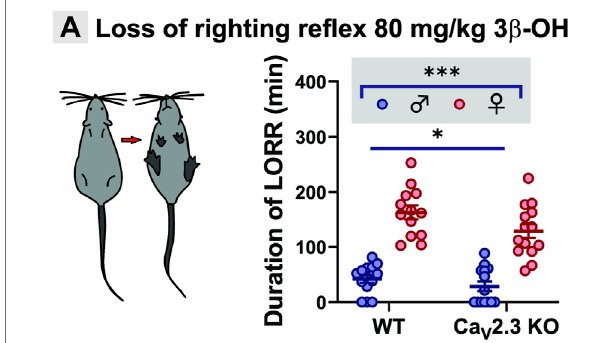
FIGURE 4 | Sex- and genotype-dependent resistance to hypnosis measured by LORR in the Ca V 2.3 KO mice when compared to the WT littermates after i.p. injections of 80 mg/kg 3 β -OH. (A) Left, schematic presentation of LORR experiment; right, average duration of LORR after injections of 3 β -OH (two-way ANOVA: interaction F 1,51 = 0.99, p = 0.320; genotype F 1,51 = 5.15, p = 0.027; sex F 1,51 = 112.00, p < 0.001). N = 13 – 14 animalsinWTgroup; N =13 – 14animalsinCa V 2.3KOgroup,* p < 0.05,*** p <